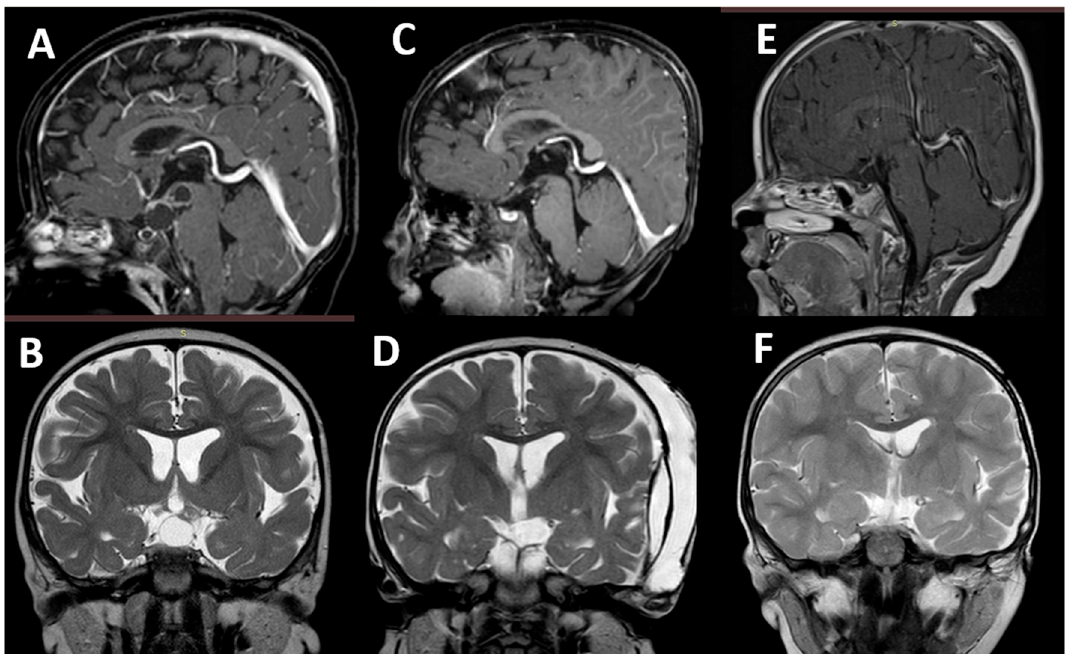
Figure 2. Preoperative MRI (( A ): sagittal T1 after gadolinium, ( B ): coronal T2) of a 6-year old boy with craniopharyngioma with sellar/suprasellar extension and extended up to the interpeduncular cistern. The immediate postoperative MRI (( C , D ), same MRI sequences) shows the tumor was removed without significant brain damage but with subdural hygroma and subcutaneous CSF collection. The patient developed postoperative epilepsy associated to hyponatremia. ASMs were discontinued 4 years after surgery. At that time, MRI was normalized (( E , F ), same MRI views).